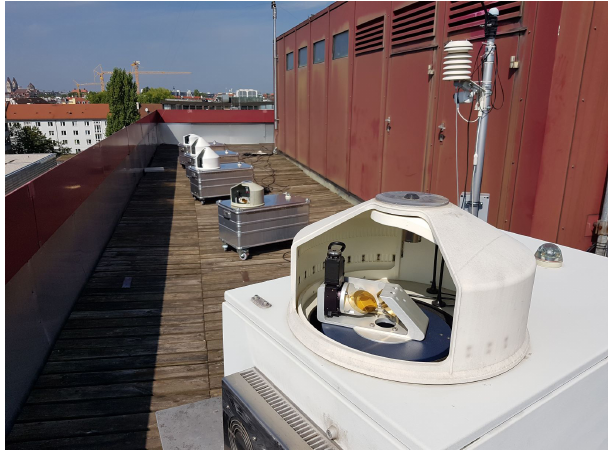
Figure 10. Calibration measurements of all our five sensor systems on the roof of our institute’s building. One can see four slightly different versions of our enclosure systems.